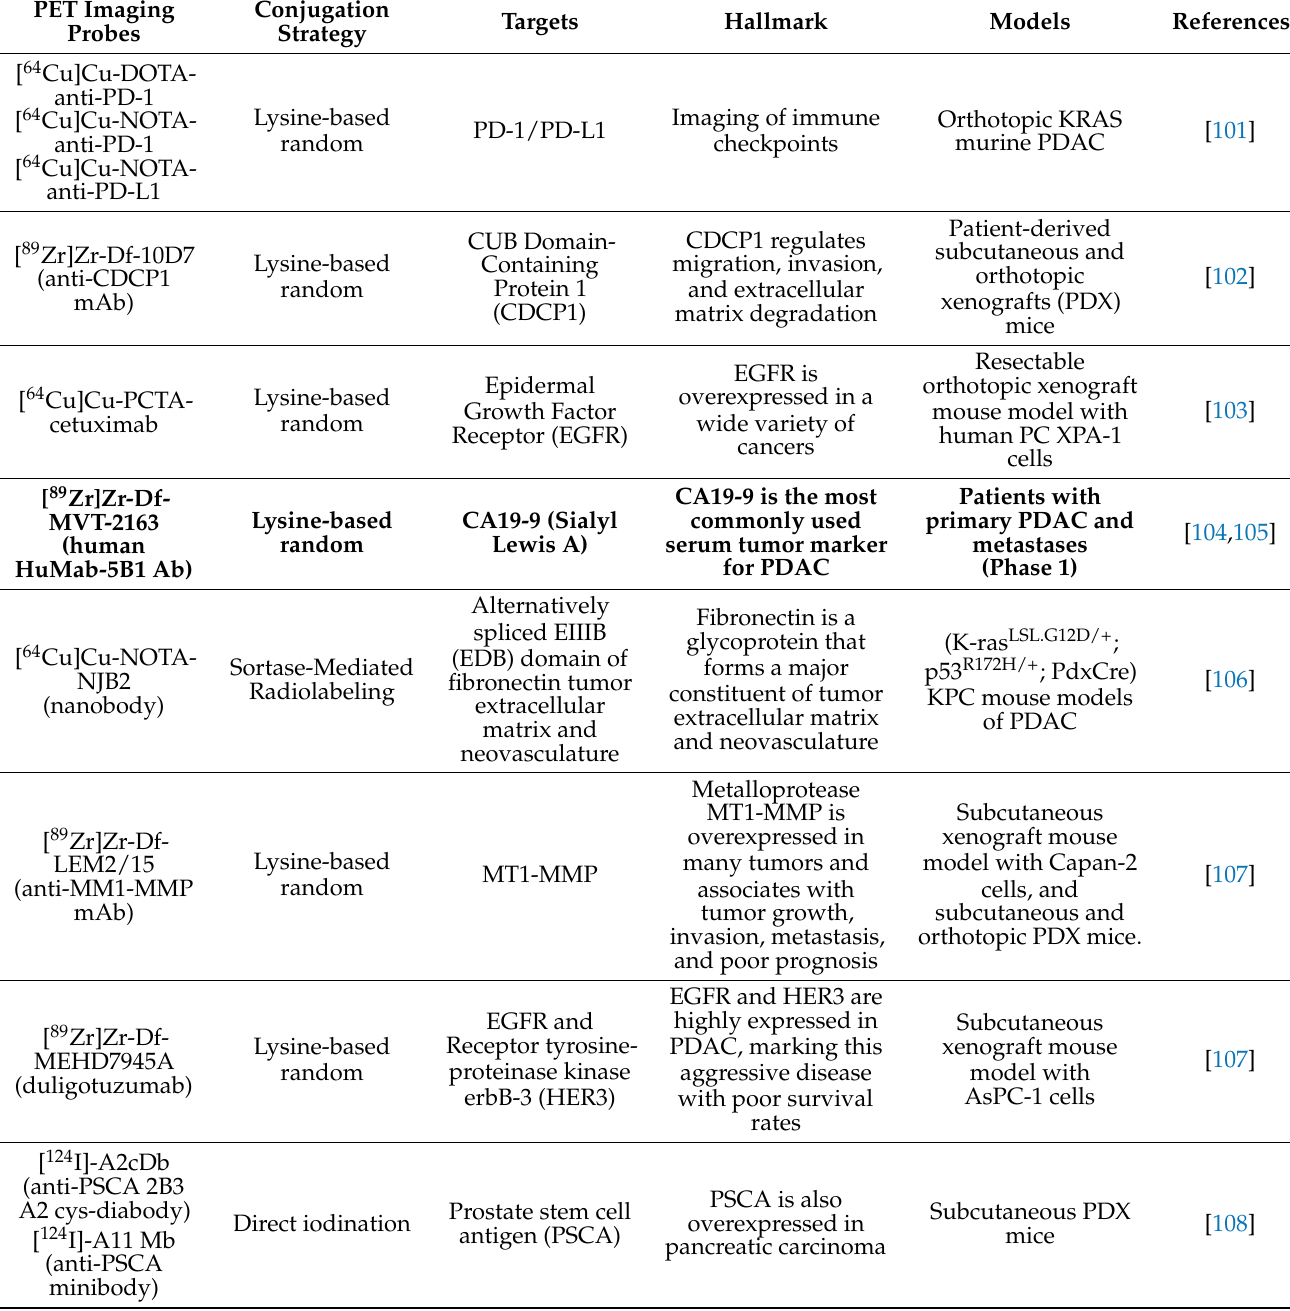
Table 2. Immuno-PET applications in